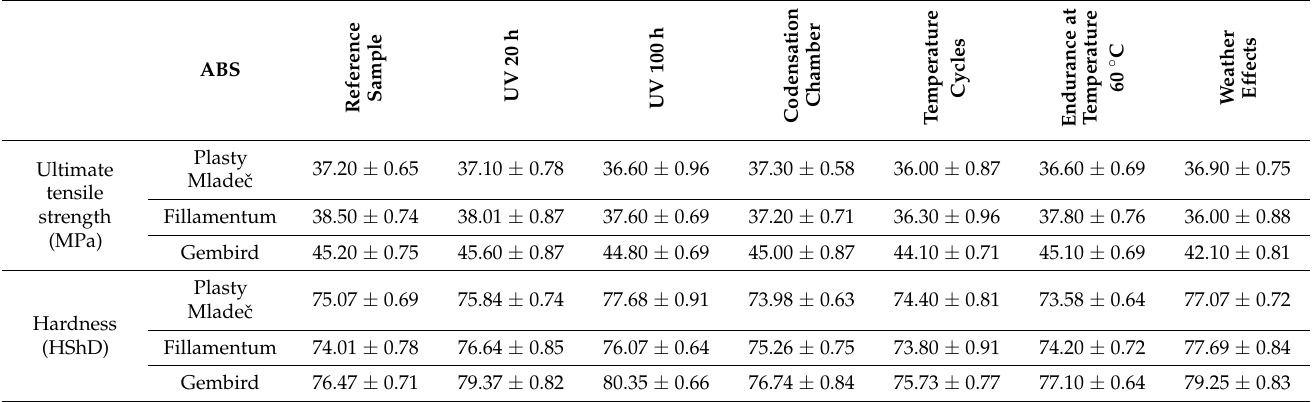
Table 7. Measured results—ABS